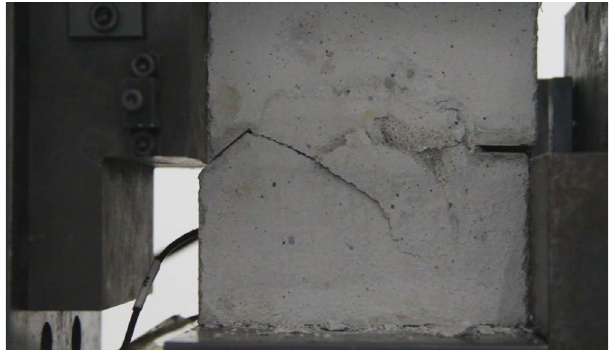
Figure 64. Photograph showing penetration patterns of the tip of the left crack and the tip of the right crack indirectly expand and